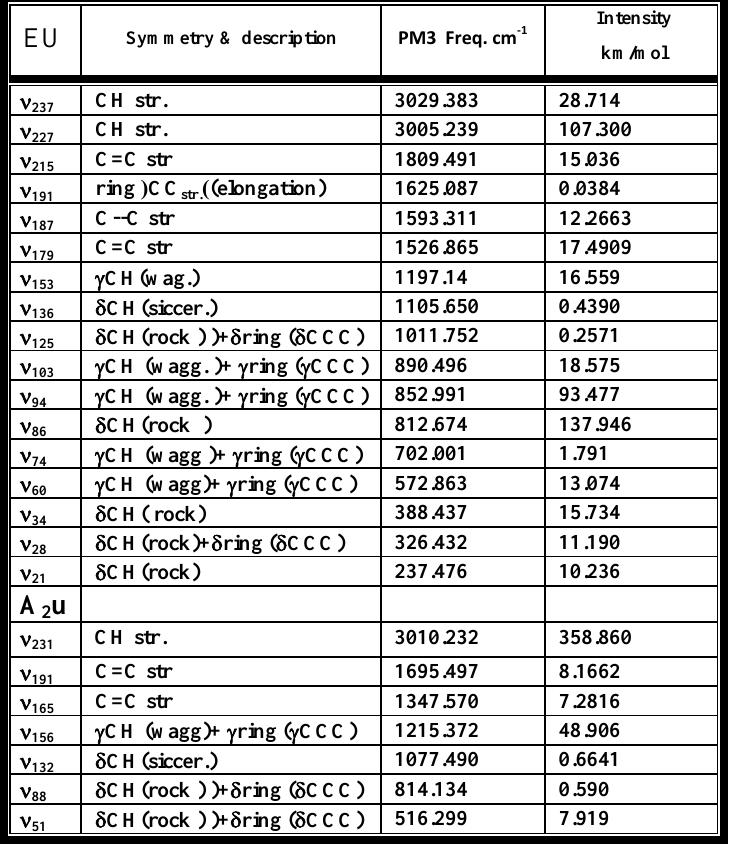
H ) molecule 56 28